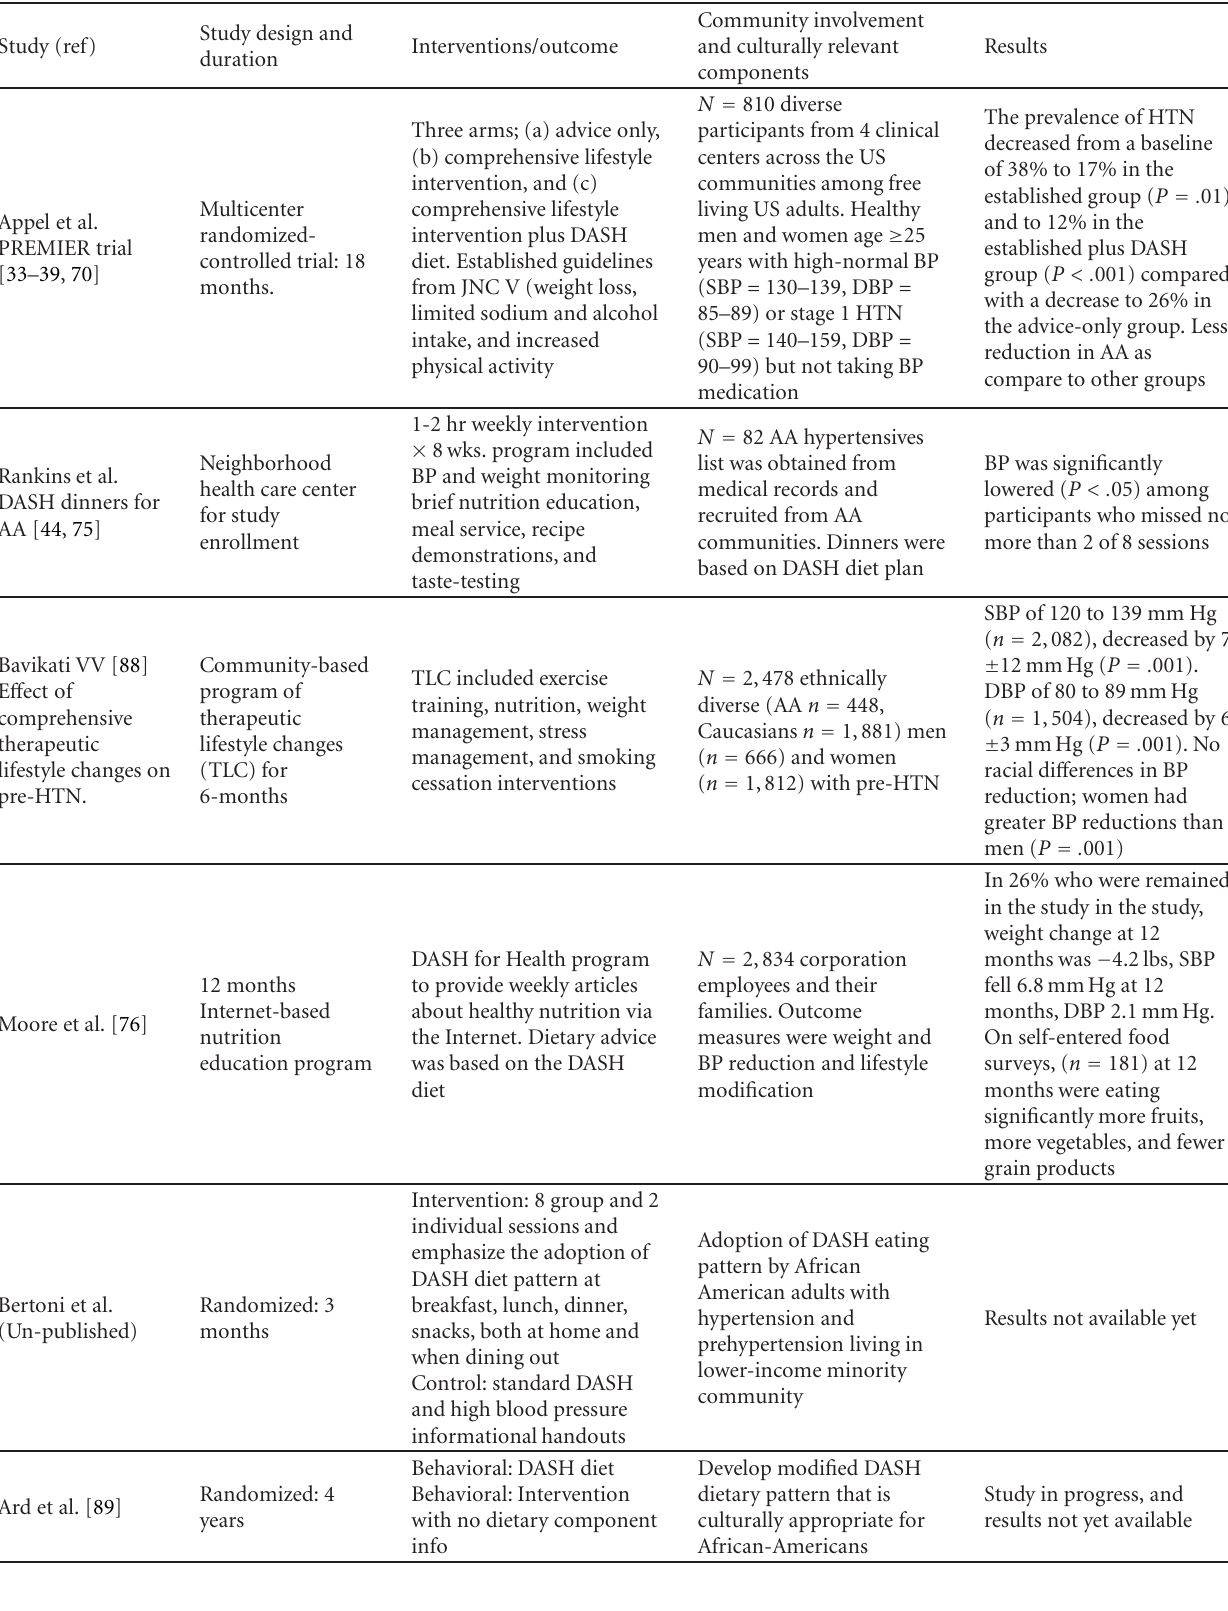
Table 2: Population-based DASH interventions to prevent or treat HTN in AA